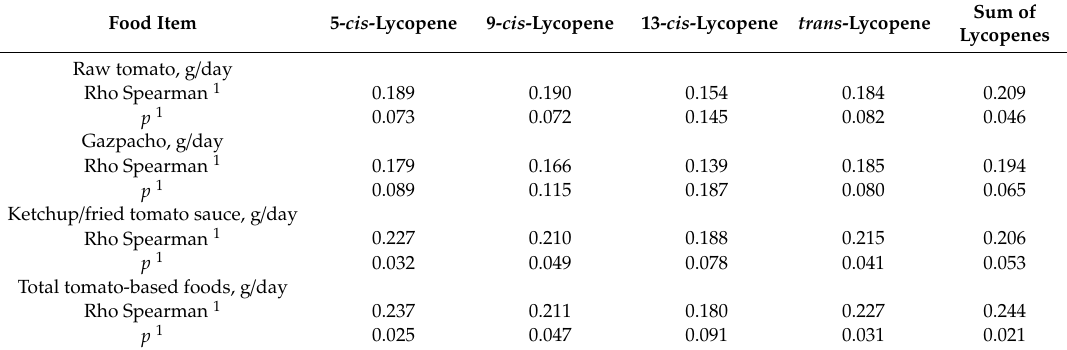
Table 2. Correlations between self-reported dietary intake of tomato-based food items and plasmatic concentrations of di ff erent lycopene